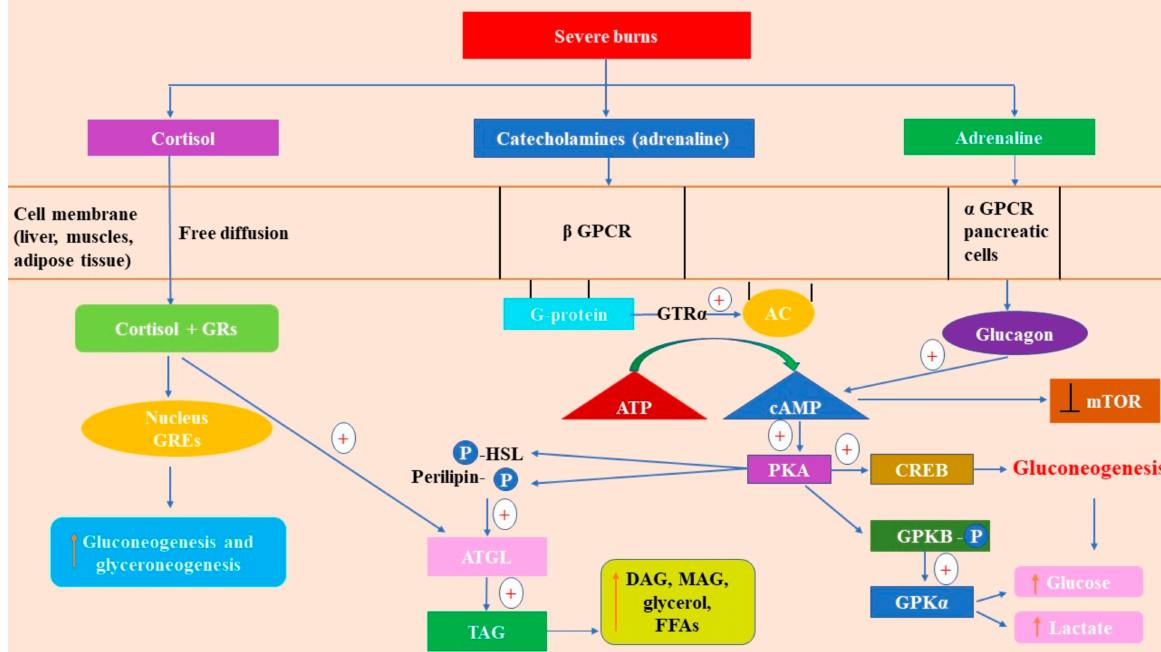
Figure 2. Stress hormones in severe burns. The released catecholamines bind to the β receptor (a G protein-coupled receptor (GPCR)), leading to adenyl cyclase (AC) activation; further, the second messenger, cyclic adenosine monophosphate (cAMP), is formed by adenosine triphosphate hydrolysis (ATP), leading to protein kinase B (PKB) activation. PKA phosphorylates glycogen phosphorylase b kinase (GPKb) to its active form, GPKa, conducing to an increased level of glucose and lactate. Moreover, PKA stimulates phosphorylation of the CREB (cAMP response element-binding protein), promoting gluconeogenesis. PKA indirectly activates the adipocyte triglyceride lipase (ATGL) after the phosphorylation of perilipin and hormone-sensitive lipase (HSL), with the release of diacylglycerol (DAG), monoacylglycerol (MAG), glycerol, and FFAs. In α -pancreatic cells, adrenaline stimulates the release of glucagon which activates cAMP and inhibits the mammalian target of rapamycin (mTOR). Cortisol binds to glucocorticoid-responsive elements (GREs) that enter the nucleus and promote gene transcription of the key enzymes from gluconeogenesis and glyceroneogenesis. “ ” marks an increase; “ ” shows an inhibitory effect; “ ” indicates stimulatory